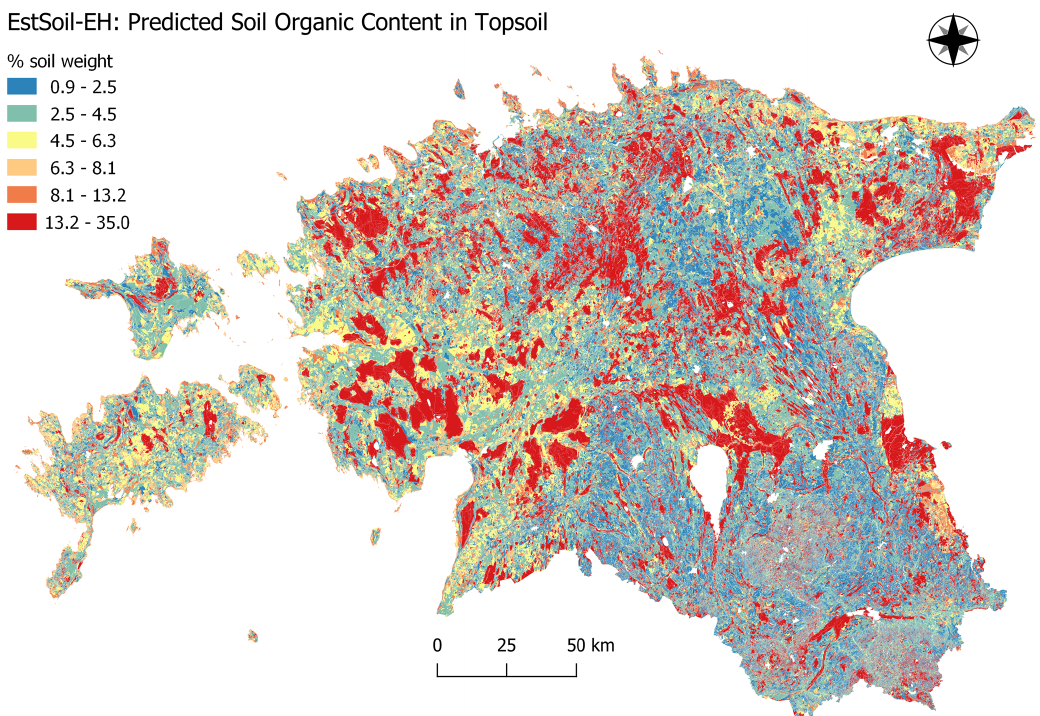
Figure 5. Predicted soil organic carbon (SOC) of the top soil layer.